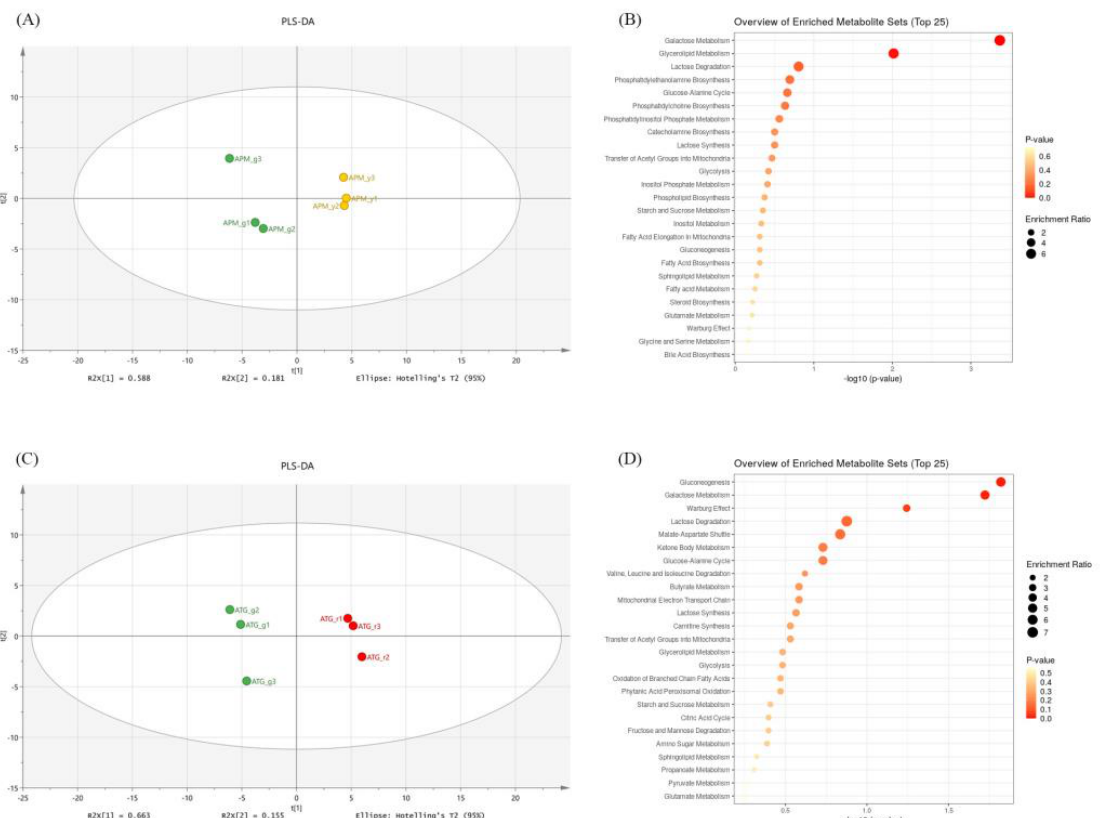
Figure 5. PLS-DA and metabolic pathway enrichment analysis in APM and ATG leaves in different seasons: ( A , B ) APM; ( C , D ) ATG. Based on the criteria of VIP ≥ 1 and p ≤ 0.05, differentially expressed compounds were screened. The results showed that in the comparison between green and yellow leaves of APM, differential compounds can be clearly grouped into three main clusters based on their seasonally specific accumulation patterns. Clusters 2 and 3 aggregate more compounds and have higher accumulation in the green leaf stage (Figure 6A). In ATG, the differential compounds were divided into four main clusters. Clusters 1 and 2 had